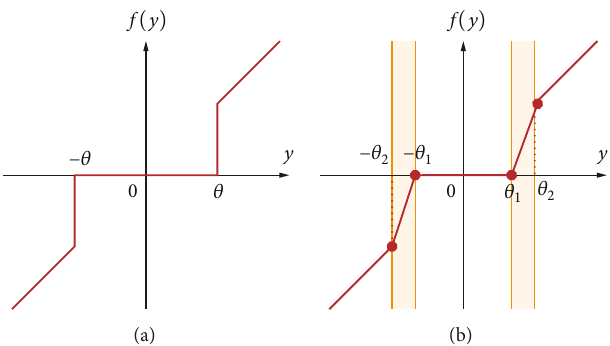
Figure 2: (a) Modeled conductance characteristic in the Josephson junction equivalent circuit. (b) Approximations of (a) by a piecewise linear